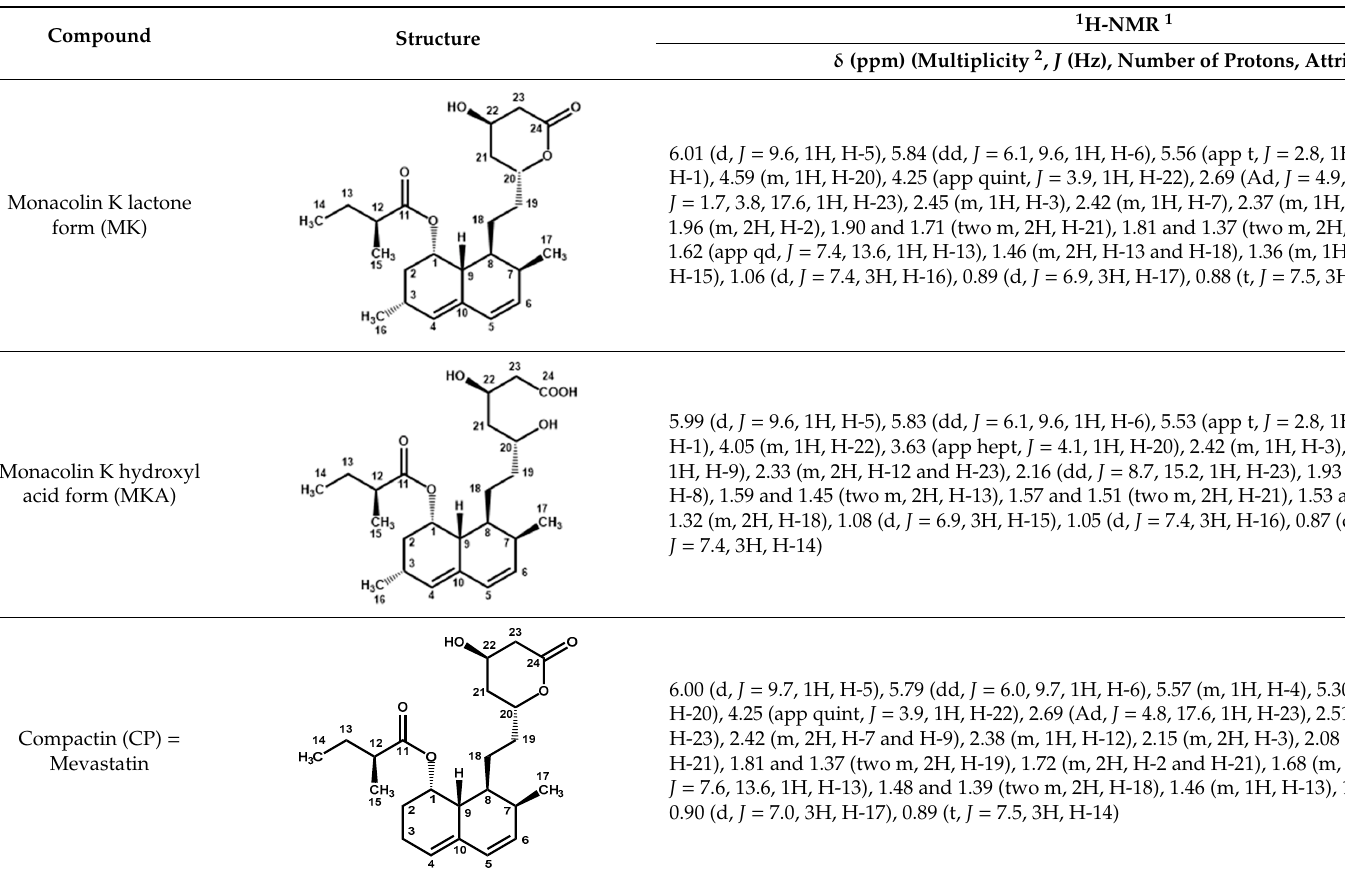
Table 2. Structures and 1 H-NMR characteristics (solvent: CD 3 CN:D 2 O 80:20) of standard monacolins and other compounds identified in this study.